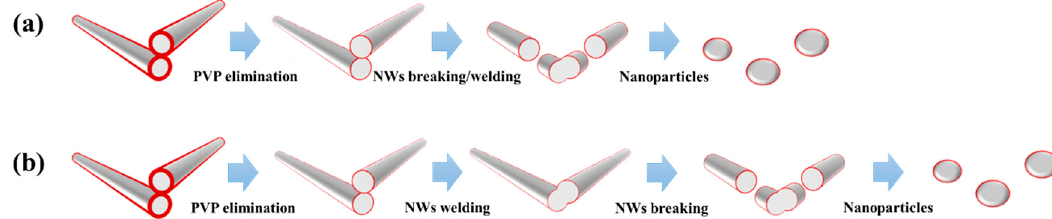
Figure 1. Schematic diagram of the morphology transformation of Ag nanowire (NW) under ( a ) thermal heating or high flash light sintering; ( b ) optimal condition of flash light sintering.